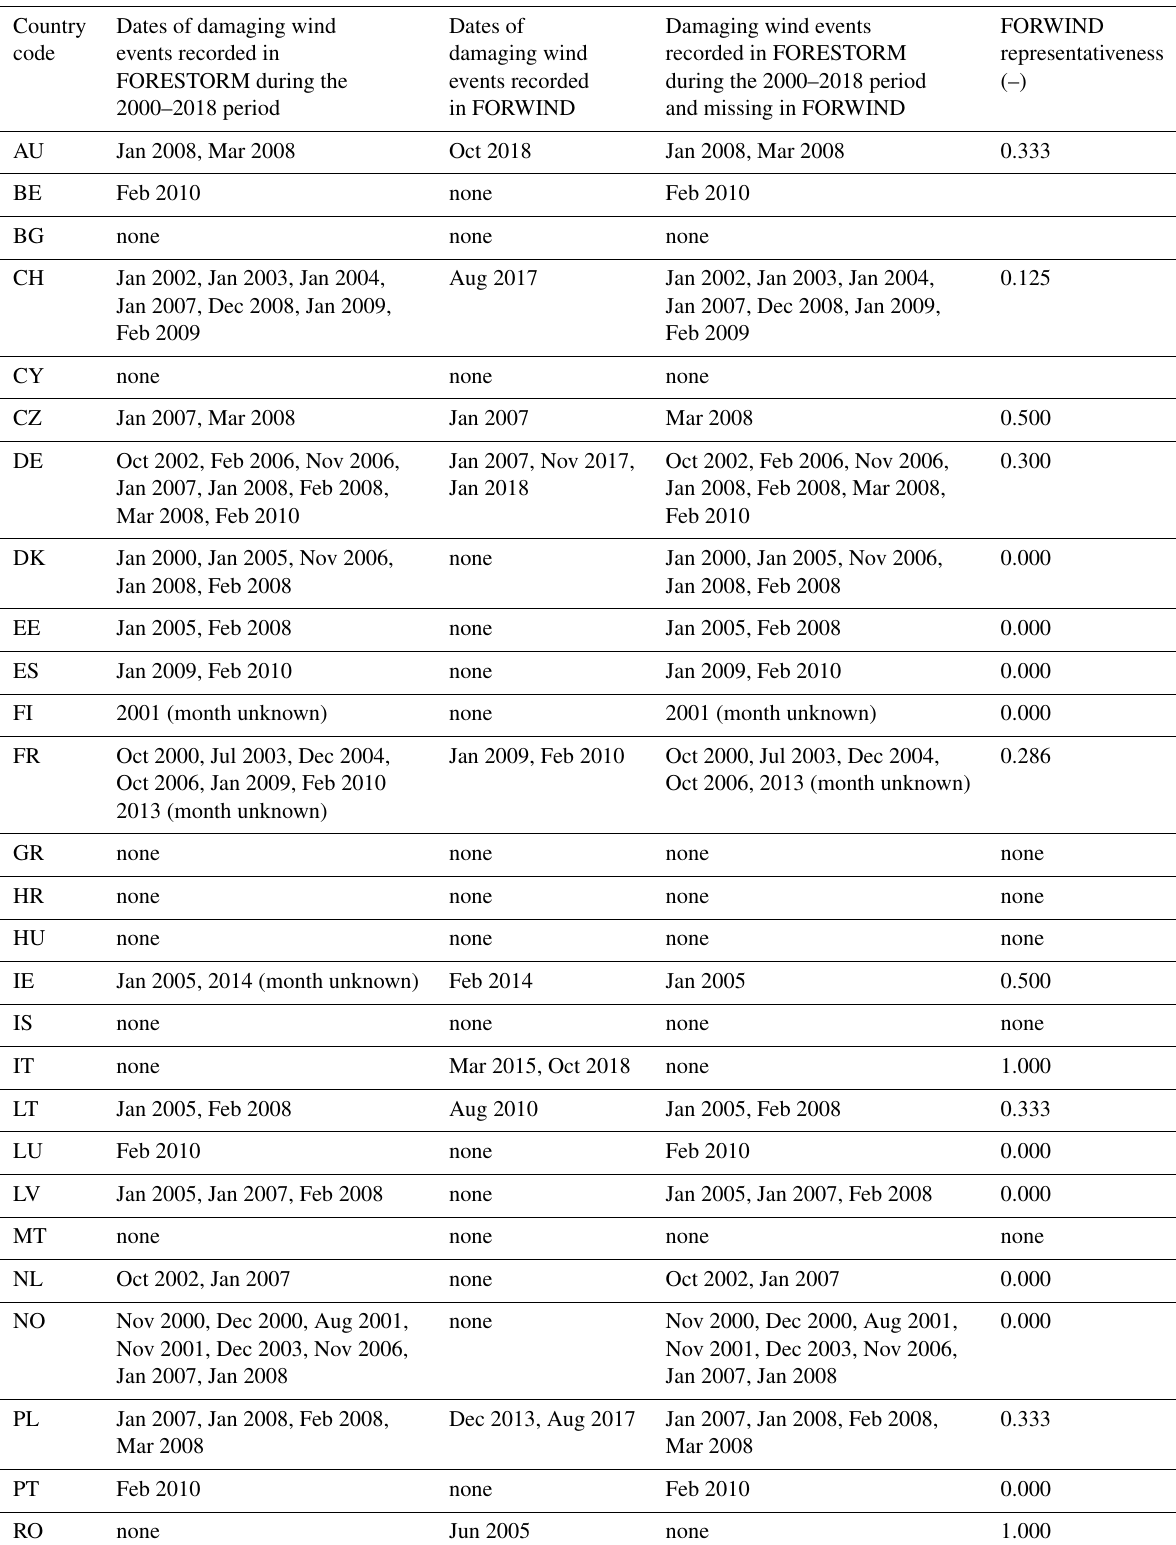
Table 5. Representativeness of FORWIND. The first estimate of representativeness at the European level accounts for damaging wind events that occurred during the 2000–2018 period in the countries currently included in FORWIND. The second estimate of representativeness at the European level accounts for all damaging events occurring during the 2000–2018 period, including those countries currently missing in